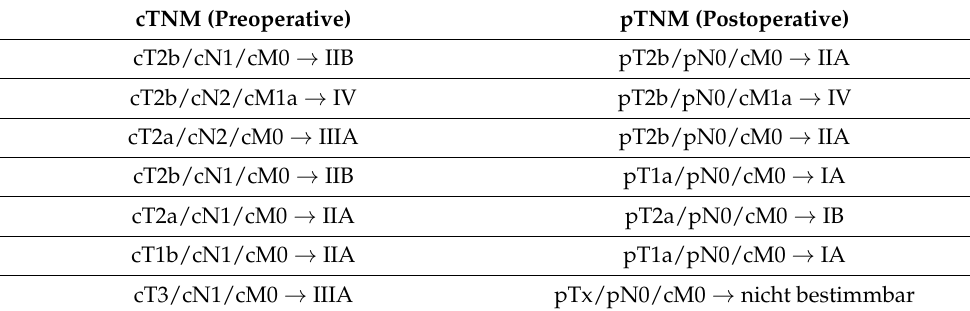
Table 9. TNM classification in group 2.2.